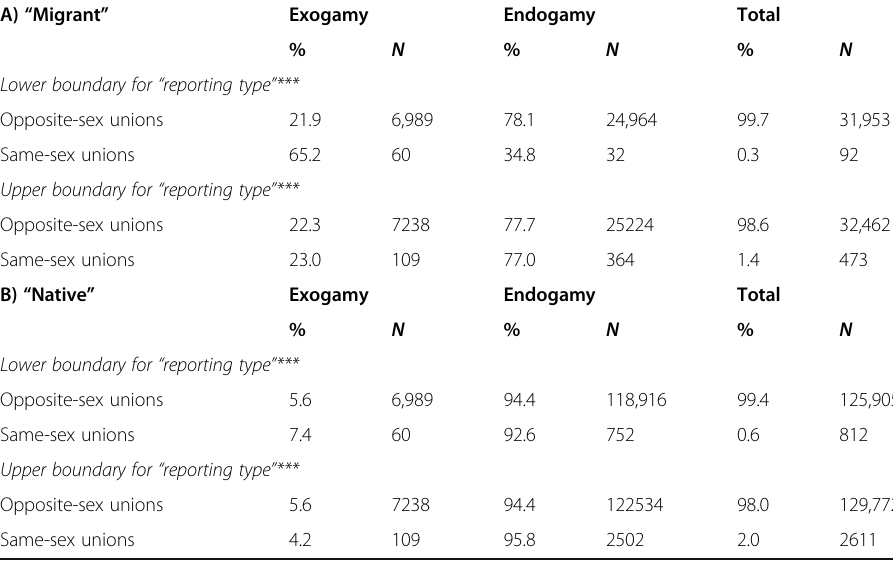
Table 3 Bivariate statistics: Union type and exogamy (in %) A) “ Migrant